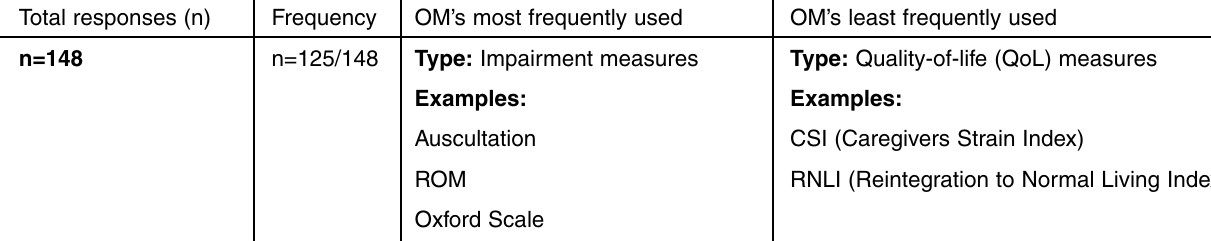
Table 2: Use of outcome measures amongst SA physiotherapists Total responses